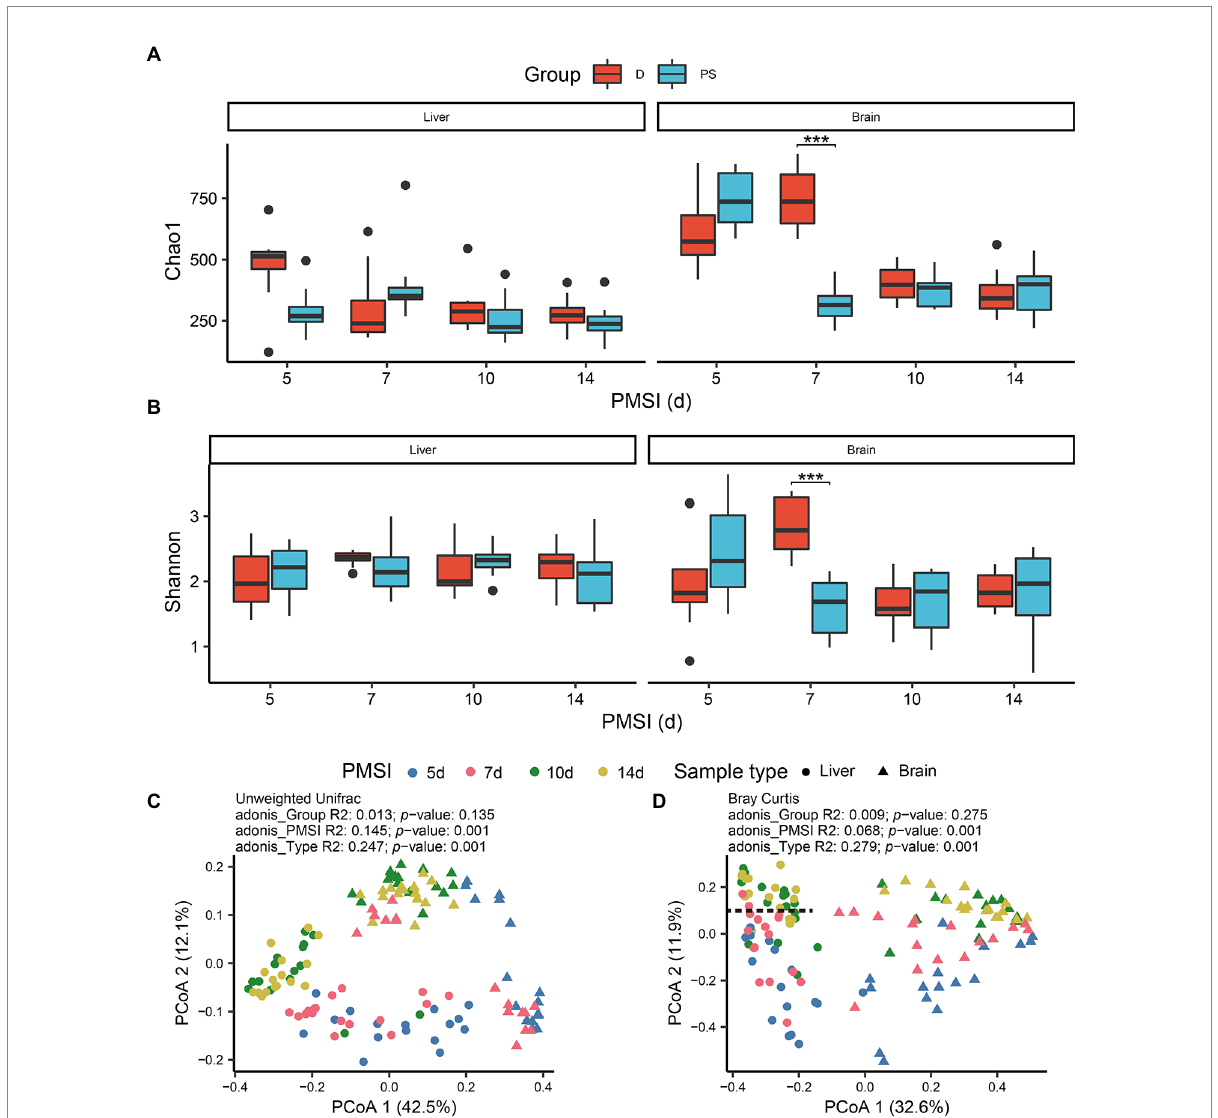
FIGURE 2 Alpha and beta diversities of microbiota in the liver and brain. Comparisons of the Chao1 (A) , and Shannon (B) , indices between drowning and postmortem groups at each PMSI. Ordination plot for the first two PCoA axes based on unweighted Unifrac (C) , and Bray–Curtis (D) , distances. Different colors indicate different PMSIs. Different sample types (liver or brain) are represented by different shapes. D, drowning group; PS, postmortem submersion